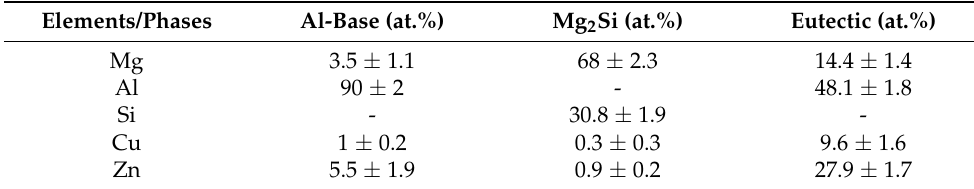
Table 6. Phases composition of the manufactured alloy in sample 1M obtained by EDS.